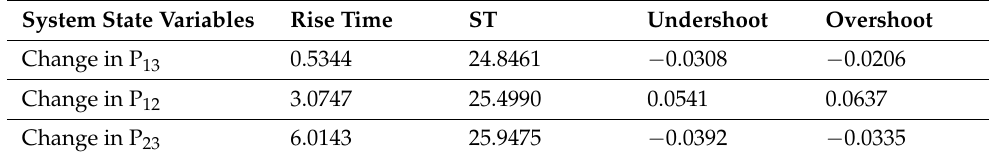
Table 6. Transient response of AGC tie-line power without controller +HVDC.